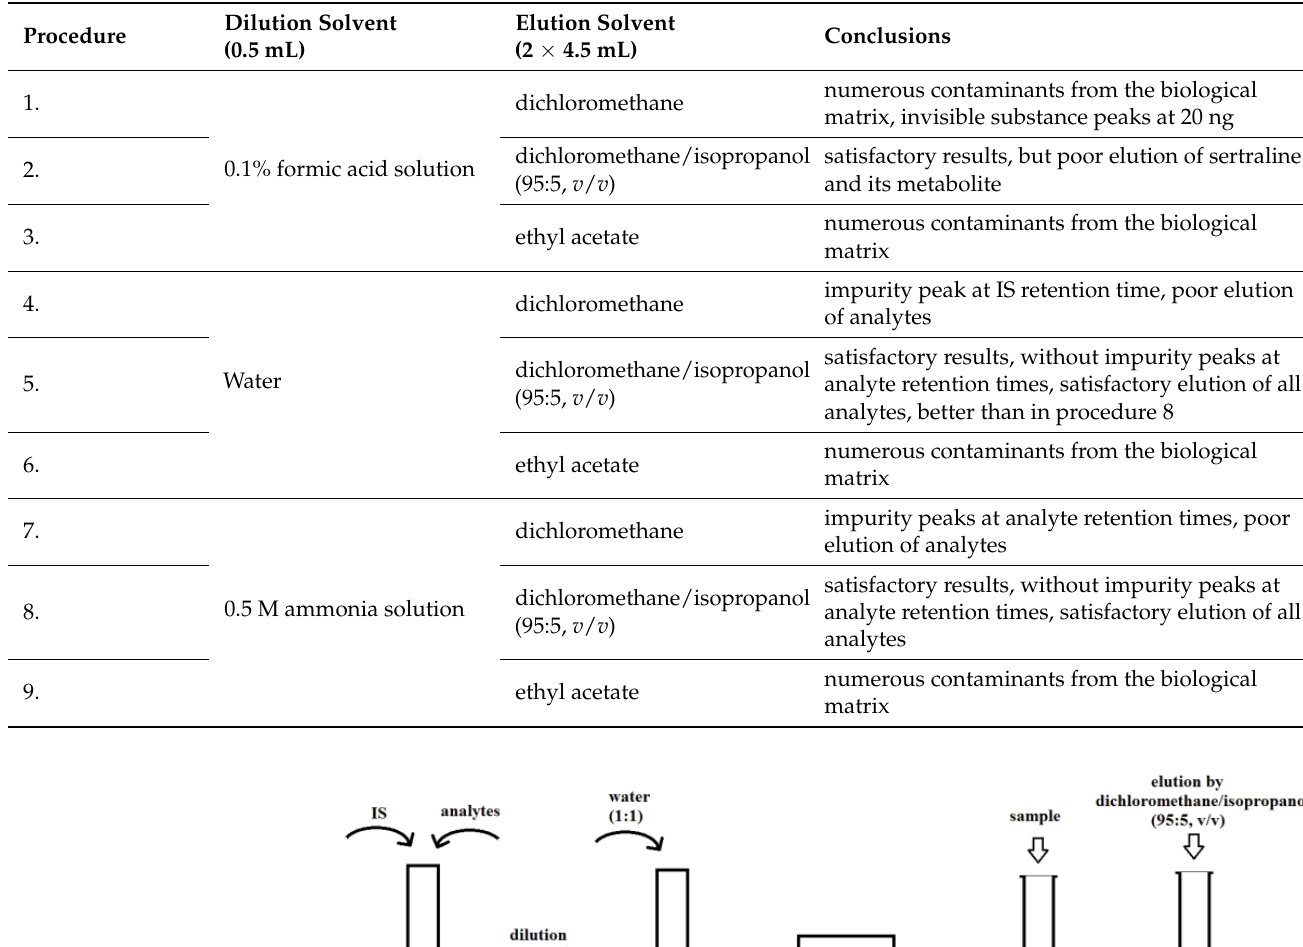
Table 1. Procedures used to examine the efficacy of supported liquid extraction (SLE).